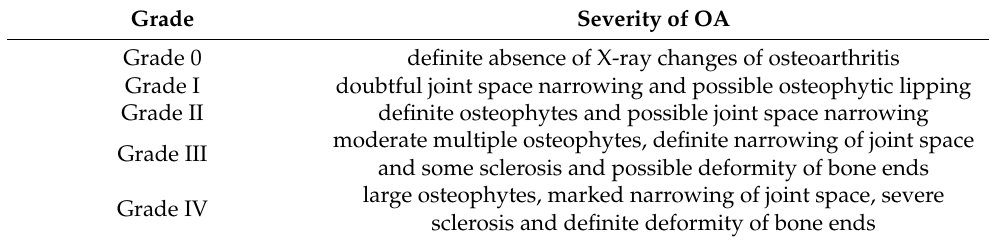
Table 4. Kellgren–Lawrence classification.